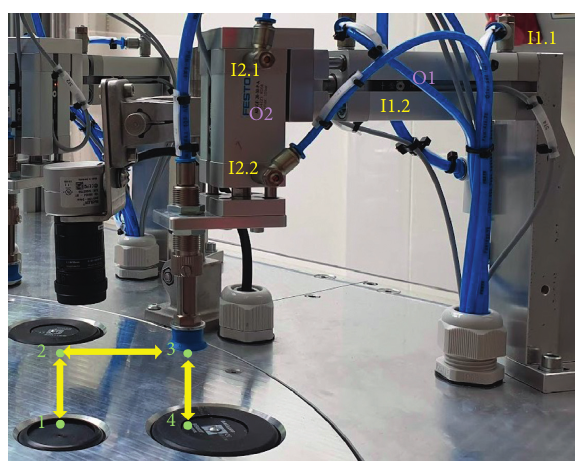
Figure 4: Pneumatic manipulator used on the